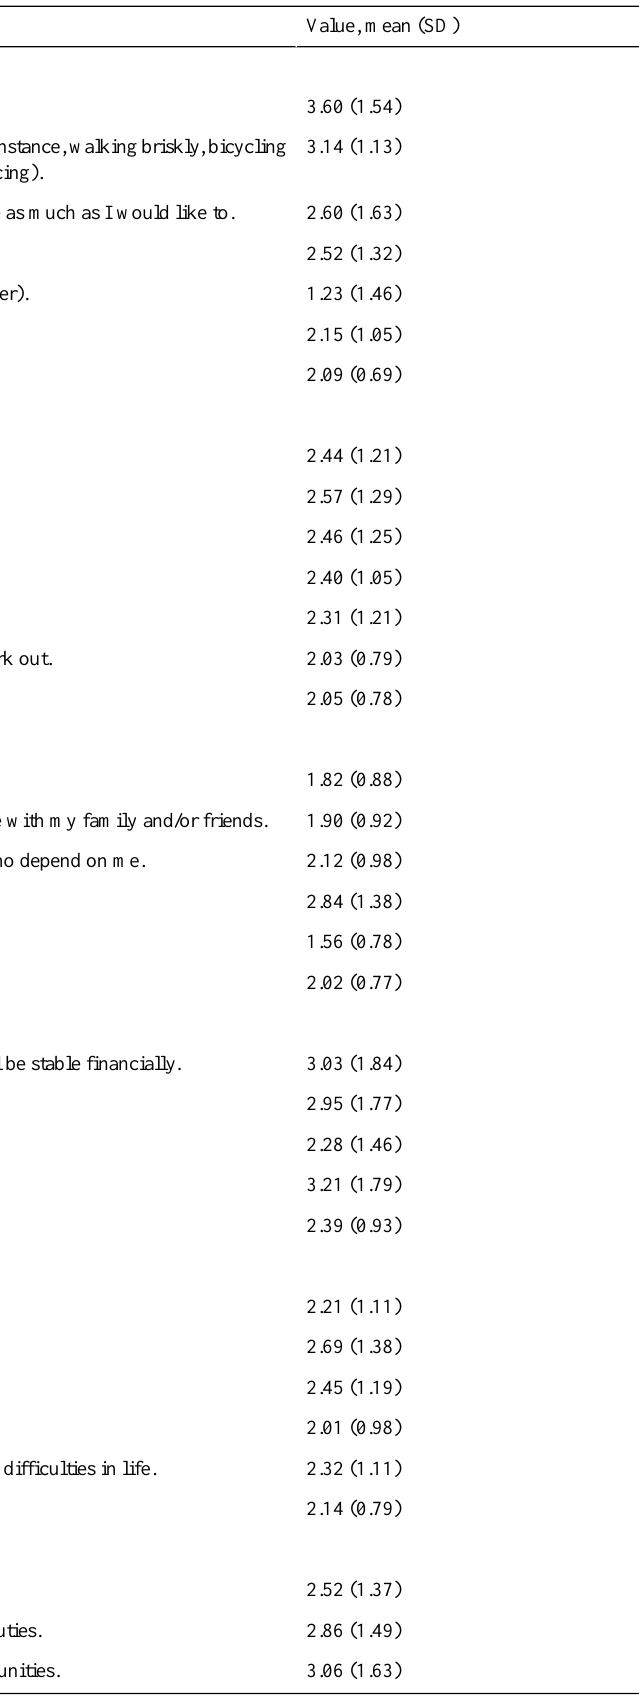
Table 4. Descriptive statistics of study participants’responses to 44 statements in the seven domains of the new scale and the reliability of each domain